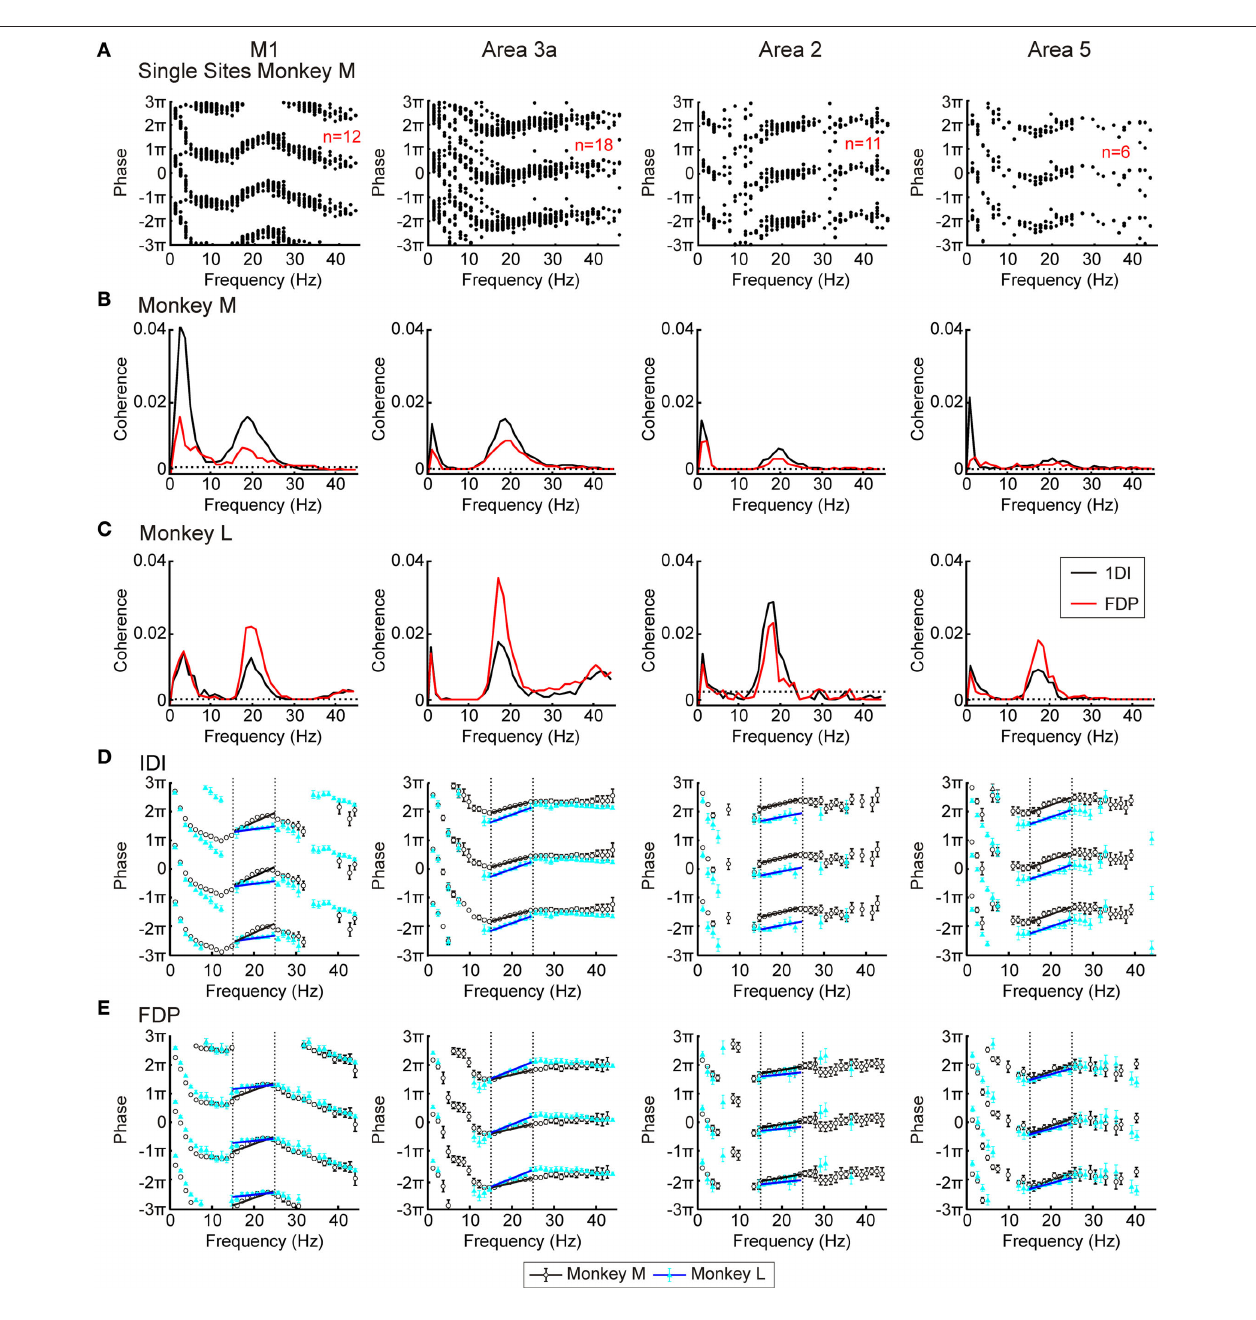
the two monkeys shown by different symbols for muscle 1DI (D) and muscle FDP (e) . Error bars represent 95% confidence limits on phase (some error bars cannot be seen since they are smaller than the plot markers). Dotted lines in (D,e) show regions used for regression analysis and black lines represent best